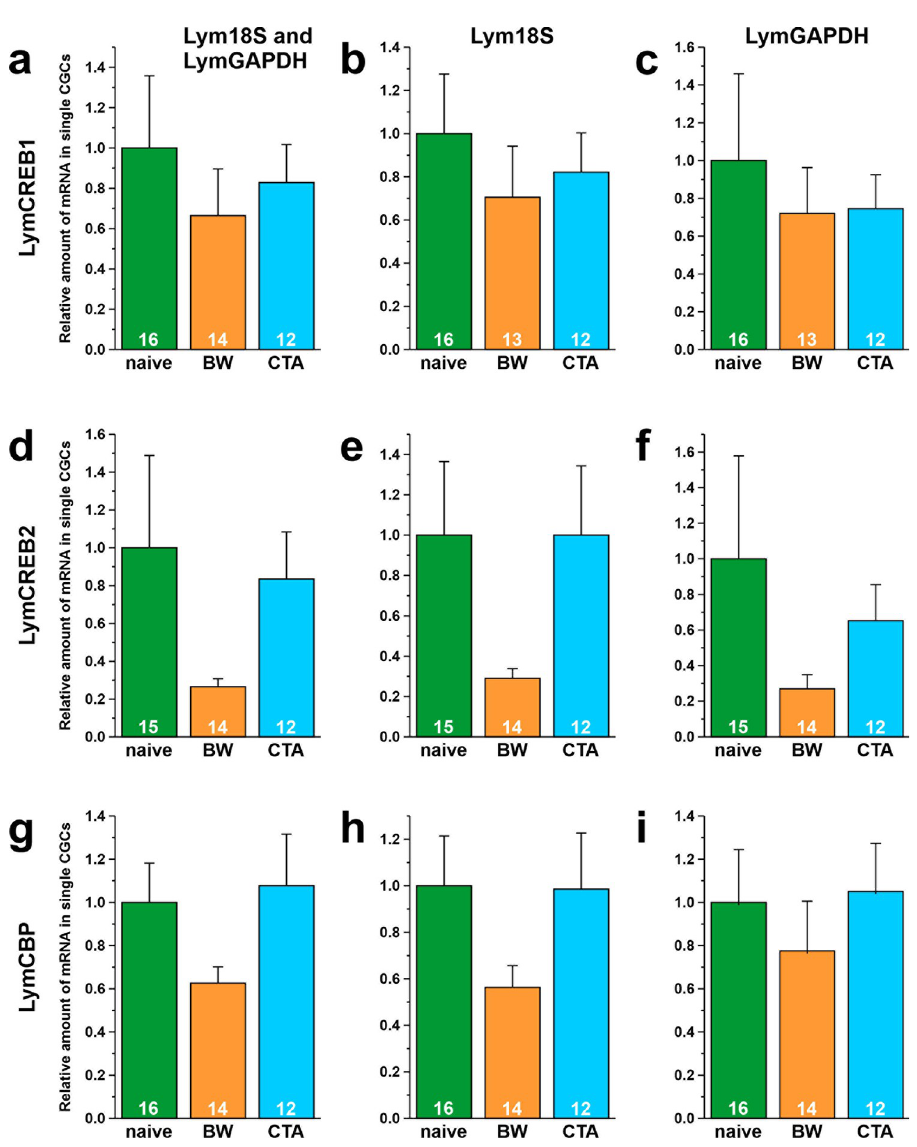
Fig 4. Comparison of reference genes for qPCR. Results of relative quantification of LymCREB1 (A-C), LymCREB2 (D-F), and LymCBP (G-I) mRNA levels. Two reference genes (A, D, G: with Lym18S and LymGAPDH) or a single reference gene (B, E, H: with Lym18S; C, F, I: with LymGAPDH) were used for normalizing the expression levels. Green, orange, and blue bars show na ï ve-control, BW-trained, and CTA-trained snails, respectively. Data are expressed as mean ± SEM. The number of samples is indicated at the bottom of the bar